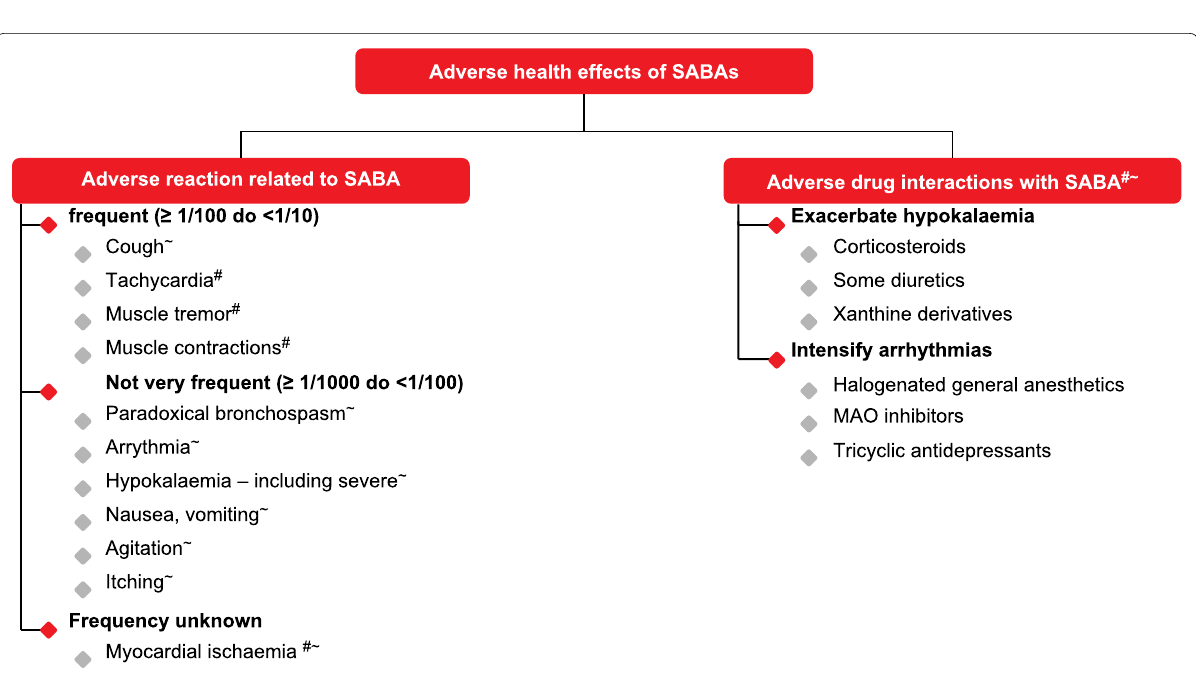
Fig. 3 Adverse effects and harmful drug interaction in patients using SABA. #salbutamol [21], ~ fenoterol